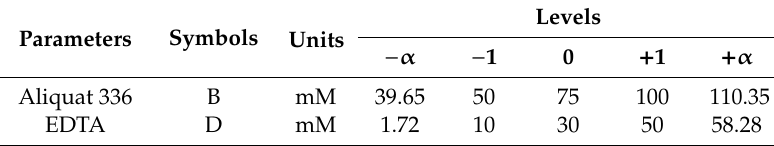
Table 3. Five di ff erent levels of parameters examined for optimization using CCD. Table 3. Five different levels of parameters examined for optimization using CCD. Parameters Symbols Units Parameters Symbols Units